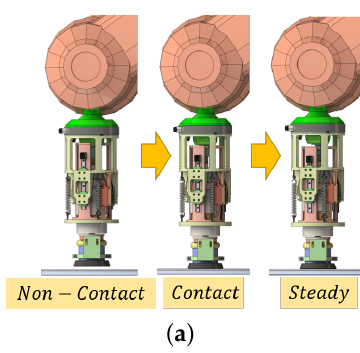
Figure 12. The polishing process of the macro-mini manipulator: ( a ) The mini manipulator is from non-contact to contact stage. ( b ) The block diagram of macro-mini manipulator’s polishing process.